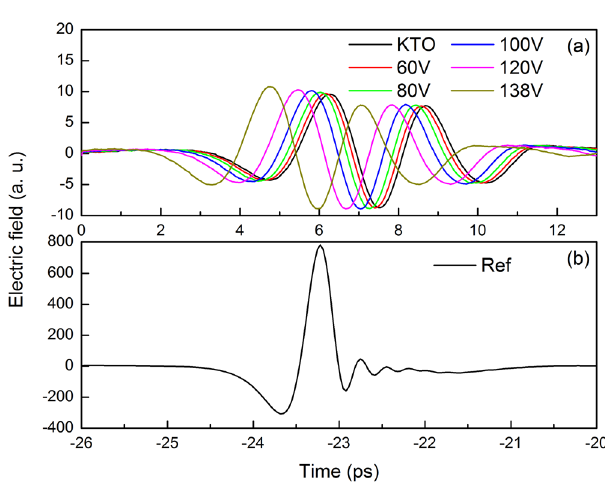
Figure 2. ( a ) Time domain transmittance waveform of KTO hybrid metamaterial sample and its time shift under external voltages at room temperature. ( b ) The reference waveform is also